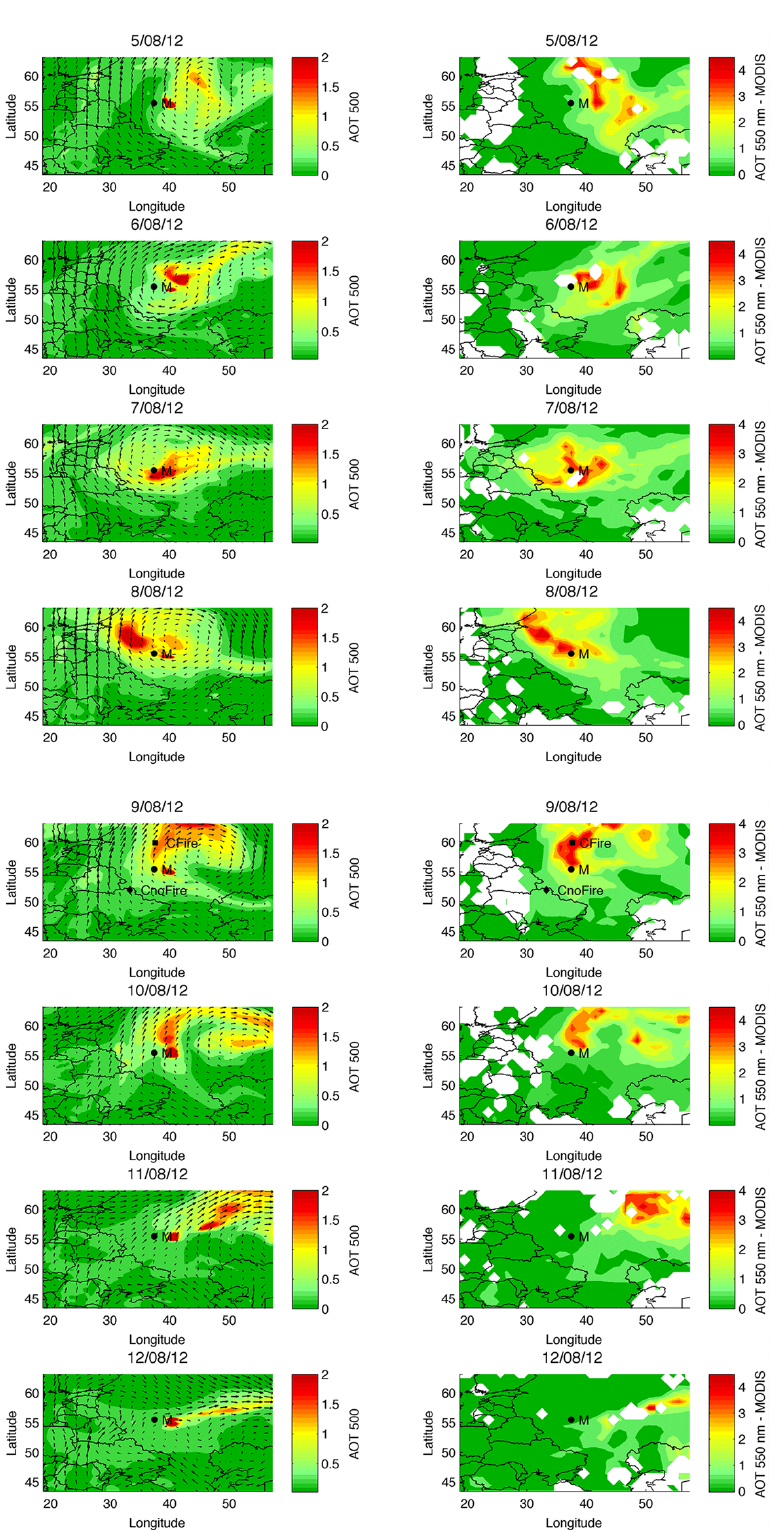
Figure 1. Geographic distribution of the AOT between 5 and 12 August 2010 modeled by CHIMERE at 500nm (left panel) and measured by the Terra MODIS (Moderate Resolution Imaging Spectroradiometer) satellite sensor at 550nm (right panel). The simulated 850hPa wind is also indicated. M is the localization of Moscow and CFire and CnoFire are the localizations of the two CALIOP profiles used in Fig.